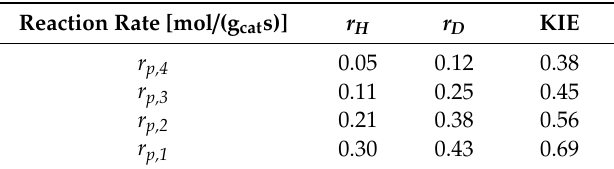
Table 6. Kinetic isotope e ff ects for the propagation rate with di ff erent carbon numbers (483 K, 1.85 bar, H 2 / CO = D 2 / CO = 10).